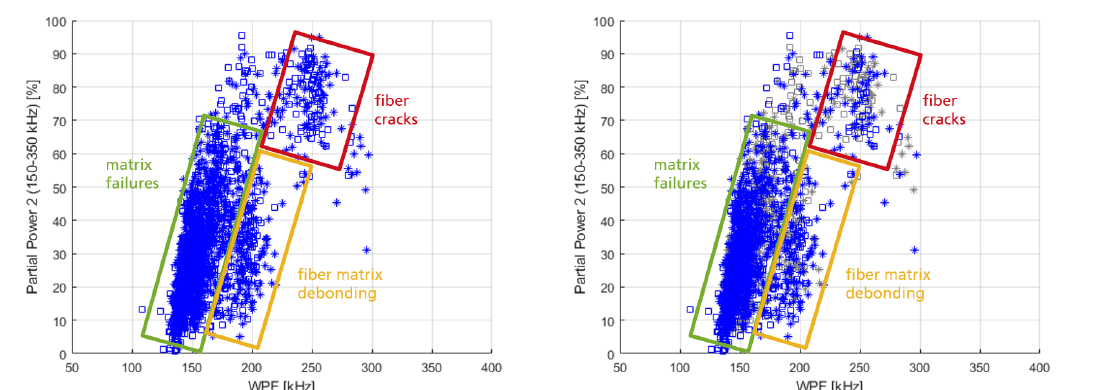
Figure 9. Partial Power 2 vs. WPF for all test specimens. Left : All acoustic events are regarded (Figure 2). Right : Acoustic events after considering a threshold of the damage index based on Figure 8. The hidden AE events are highlighted in gray, those still considered in blue. One can see a reduction of the data amount of around